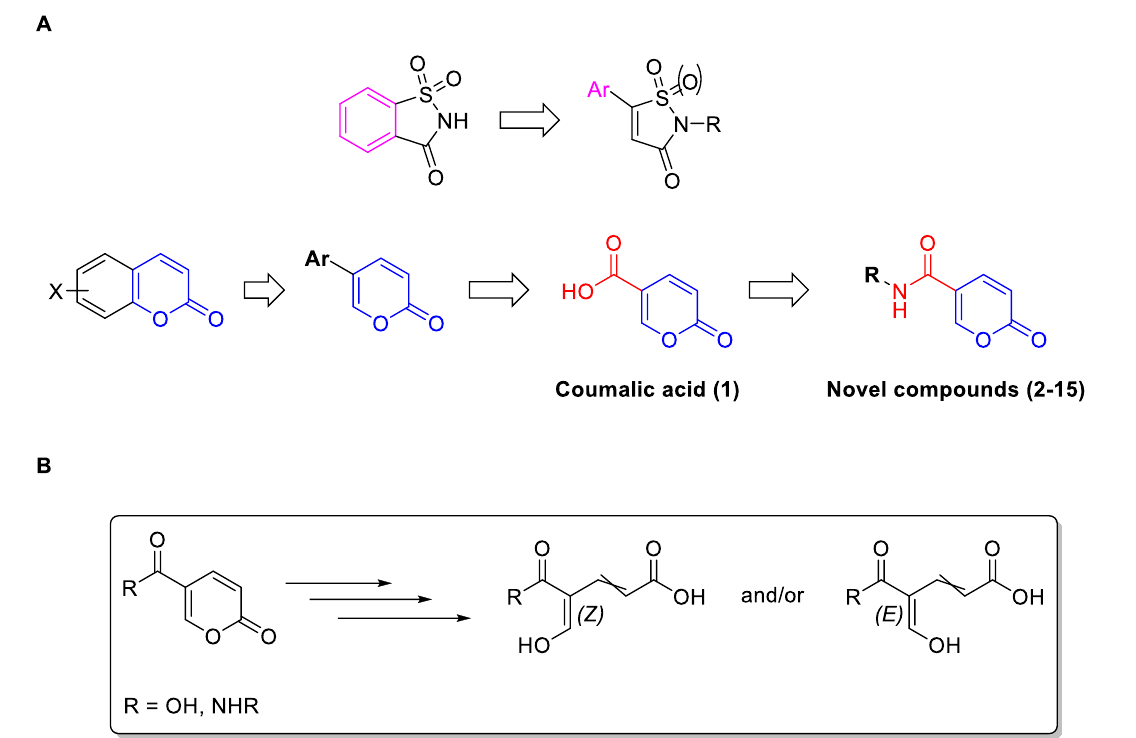
Figure 2. ( A ) Design of the novel compounds through saccharin and coumarin molecular simplification. ( B ) Possible hydrolysis pathway of compounds 1 – 15 up to the formation of the Z- or E -enol.